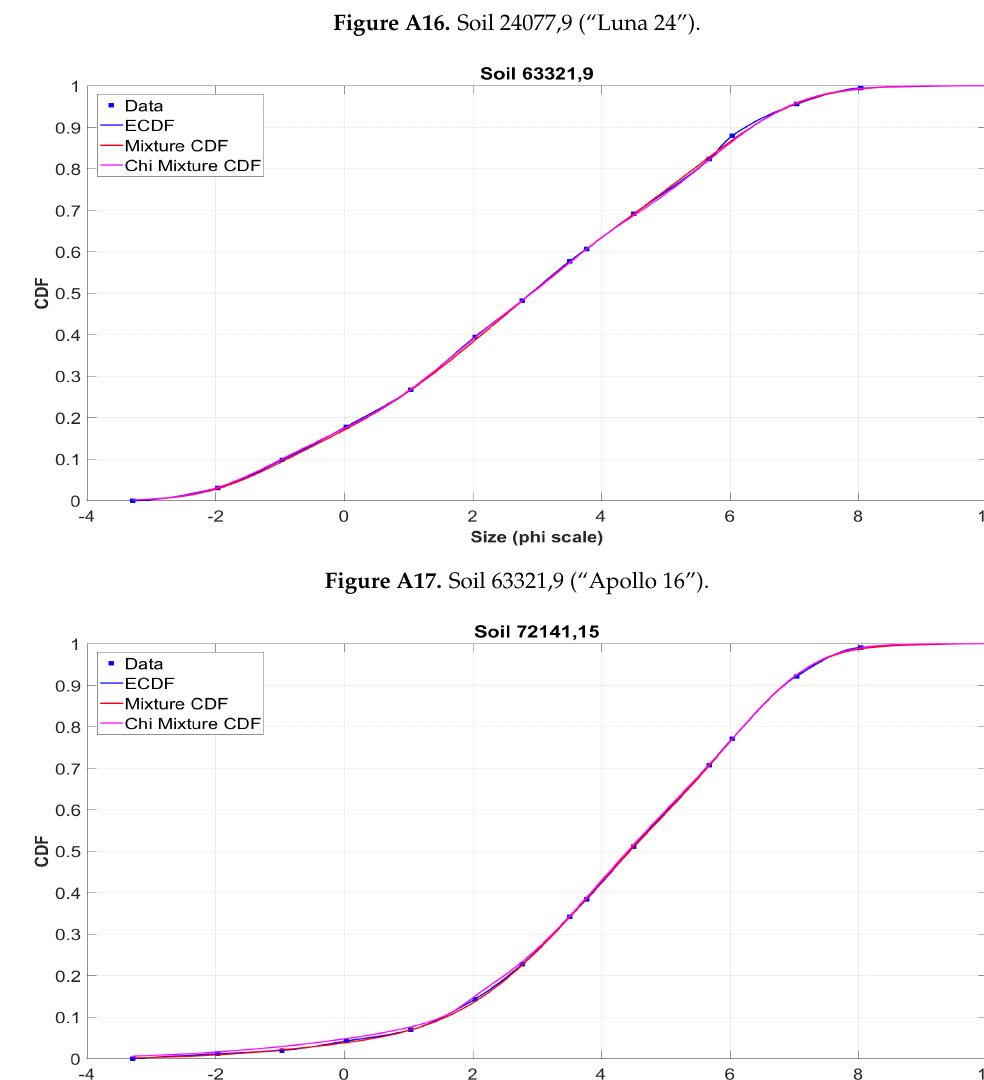
Figure A16. Soil 24077,9 (“Luna 24”).